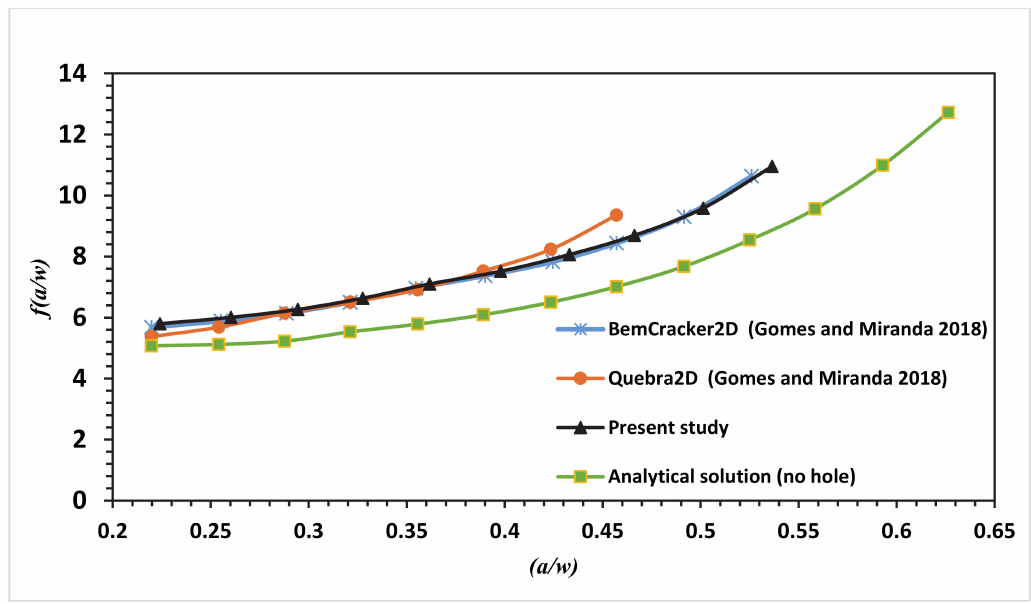
Figure 13. Dimensionless SIF of the modified compact tension specimen CTS04 compared to the work of Gomes and Miranda [16].